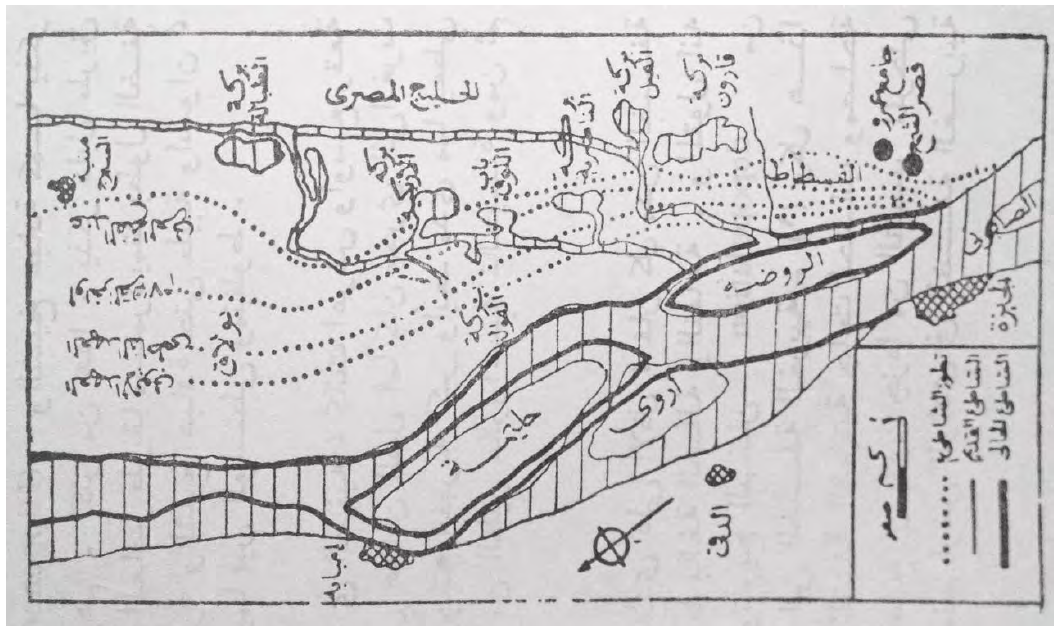
Figure 3: Main course of Nile river deviating towards west.